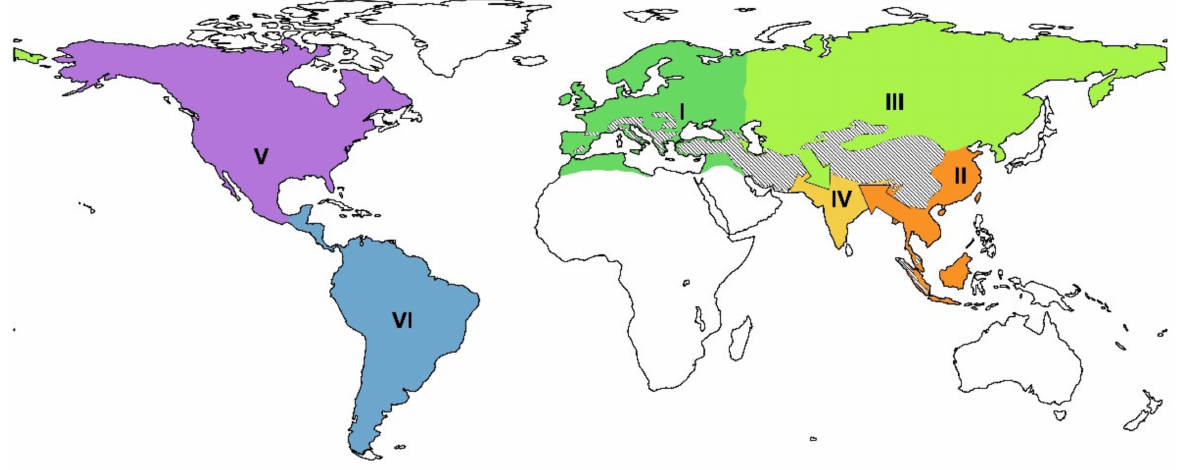
Figure 1. Zoogeographic areas based on the evolutionary history of the crown deer: I, western Palearctic (early evolutionary radiation of the subfamily Capreolinae); II, Sino-Malayan area (early evolutionary radiation of the subfamily Cervinae); III, eastern Palearctic (dispersals of Capreolinae and Cervinae); IV, western Oriental (dispersals of the subfamily Cervinae); V, Nearctic (dispersals and local evolution of Capreolinae); VI, Neotropic (second evolutionary radiation of Capreolinae). The dashed area represents the Alpine-Himalayan Mountain Belt. The green and orange arrows mark the Siva-Bactrian and Siva-Malayan dispersal